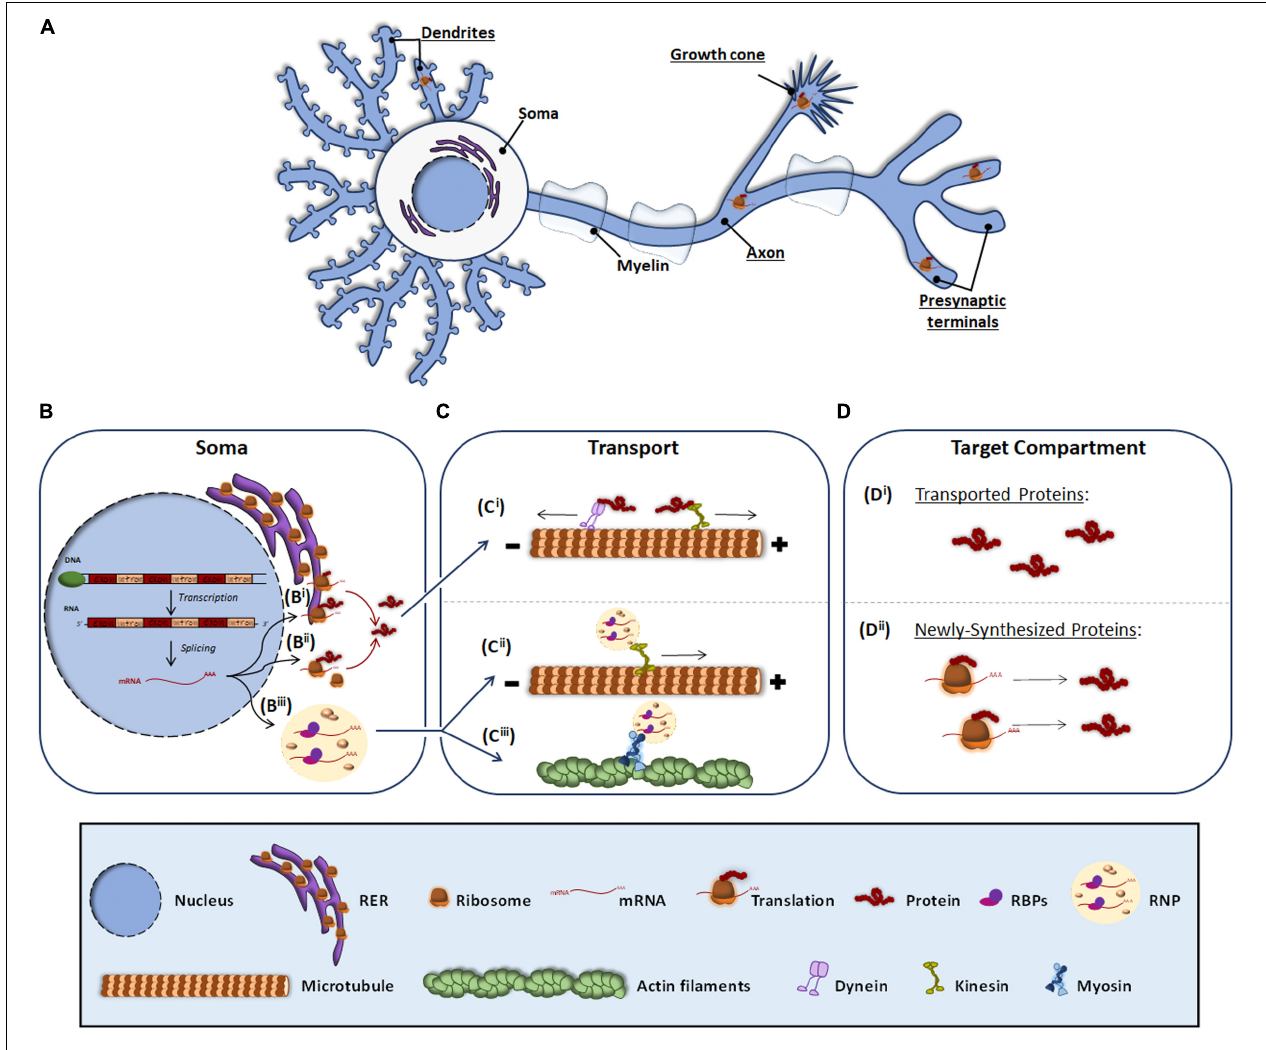
FIGURE 1 | Protein and RNA transport to peripheral subneuronal compartments. Roughly it is underlined the neuronal compartments where local protein synthesis occurs (A) . In the soma, expressly in the nucleus, DNA is transcribed to RNA and after splicing, the resulting mRNA (B) can be either processed by the classical somatic translation or the local protein synthesis. For the classical one, the mRNA is translated by ribosomes associated to RER (B i ) and free cytosolic ribosomes (B ii ) . Synthetized proteins are transported (C) through dyneins or kinesis associated to microtubules (C i ) to target compartments where elicit their function (D i ) . For local translation, mRNA is associated to RBPs and assembled as RNP granules (B iii ) , which can be transported through kinesis (C ii ) or by myosins linked to actin filaments (C iii ) . At the target compartments (D) , transported mRNAs are locally translated, and the newly synthesized proteins (D ii ) elicit their